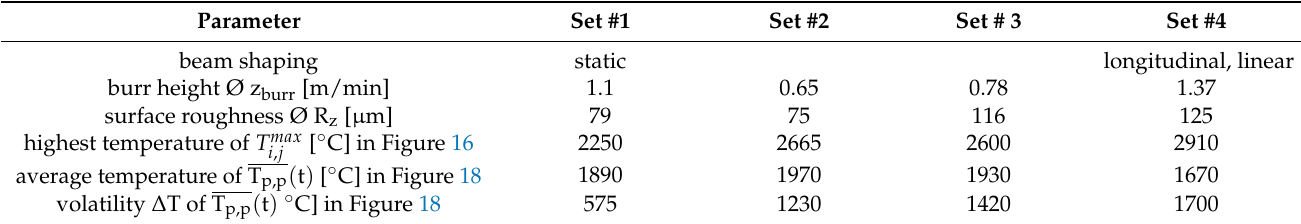
Table 6. Overview of burr height, maximum, and average temperatures and temperature volatility for static beam shaping and longitudinal, linear beam oscillation (calculated with e =